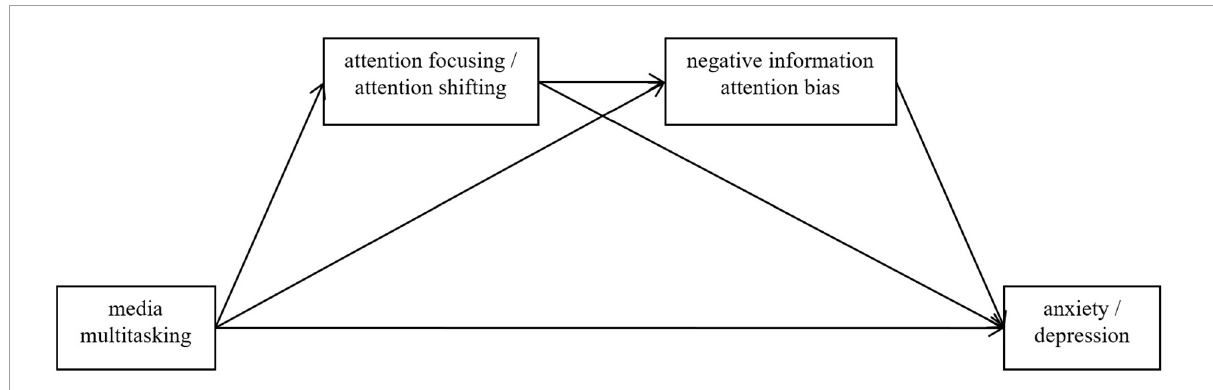
FIGURE1 The mediating pathway of attention focusing/shifting and negative information attention bias in media multitasking influence